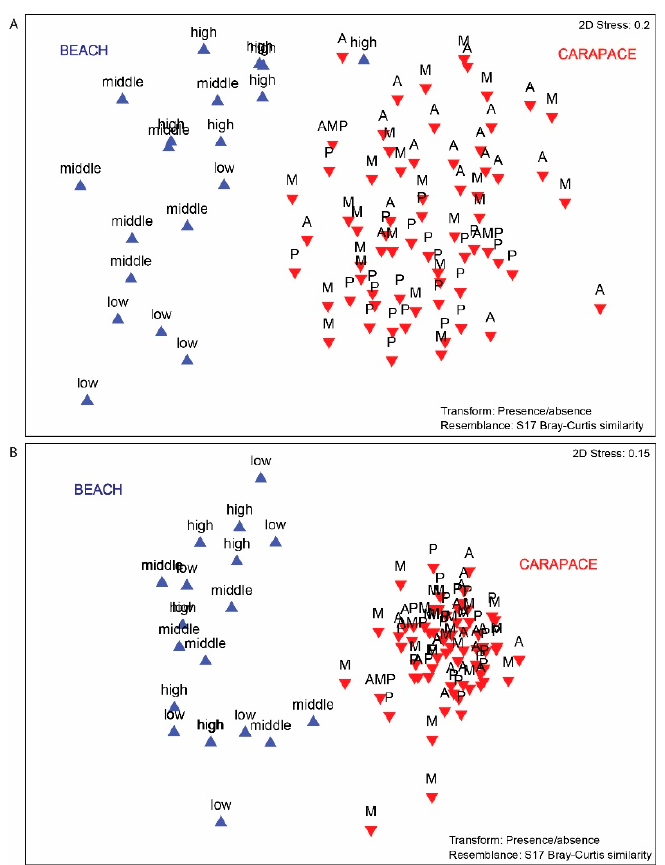
Figure 9. nMDS of ( A ) nematode genera community data and ( B ) meiofauna higher taxa data. Presence–absence transformation was used to eliminate the large abundance differences between the carapace and beach samples, making the comparison based on community composition only. Carapace samples: A = Anterior, M = Middle, P = Posterior; beach samples: high, middle and low beach.